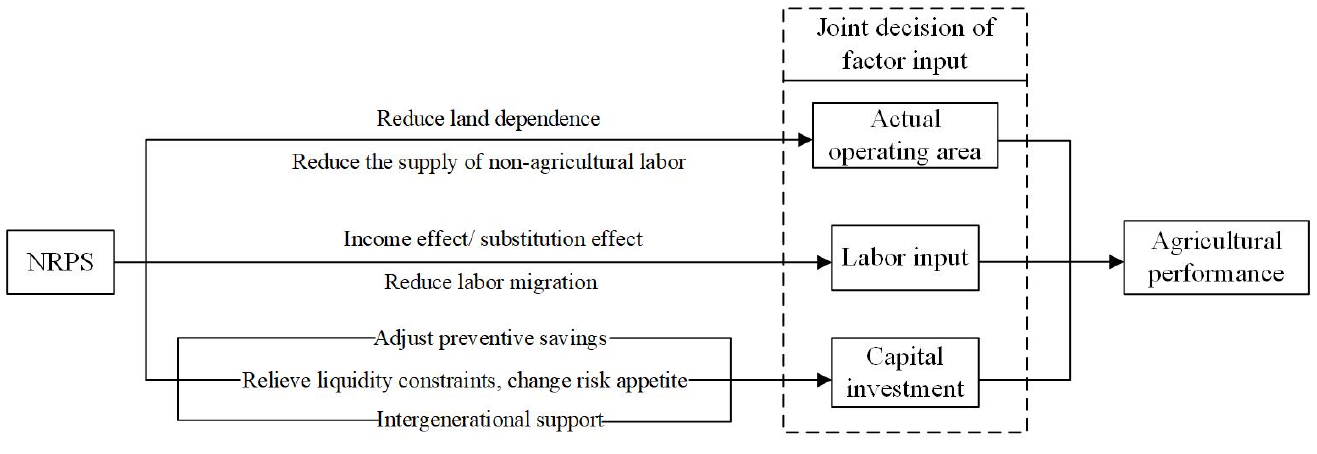
Figure 2. Theoretical